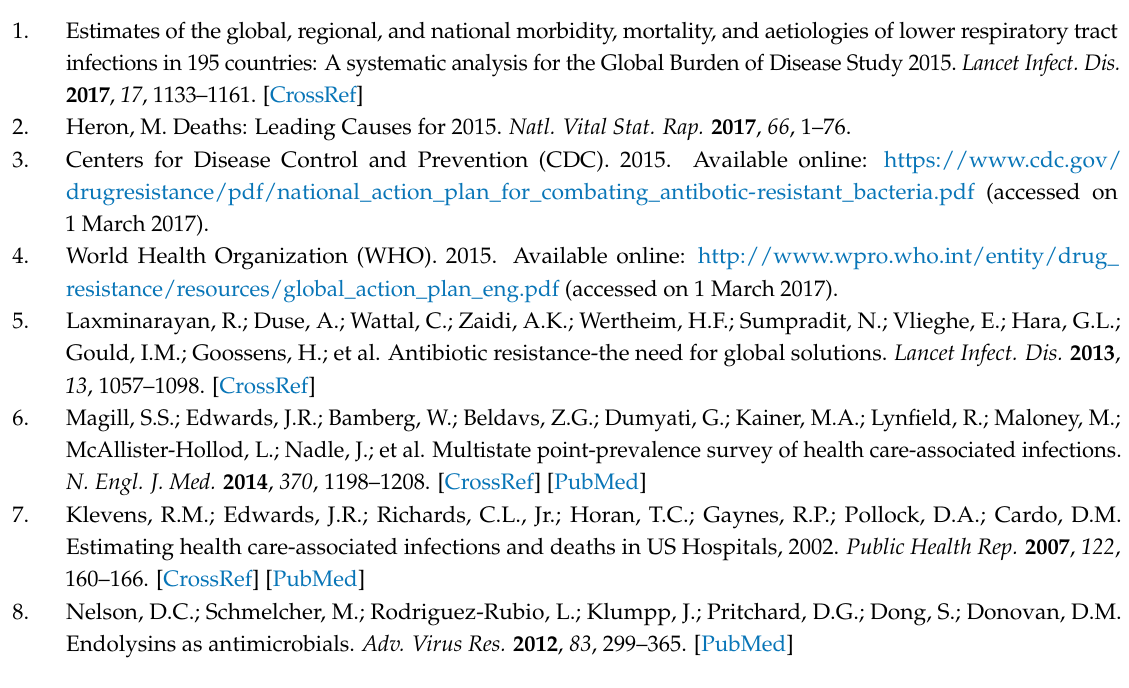
Table S1: Compilation of phage lytic enzymes that have been tested in animal models of human infections. Author Contributions: All authors, Hugo Oliveira, Carlos S ã o-Jos é and Joana Azeredo analyzed the literature and wrote the